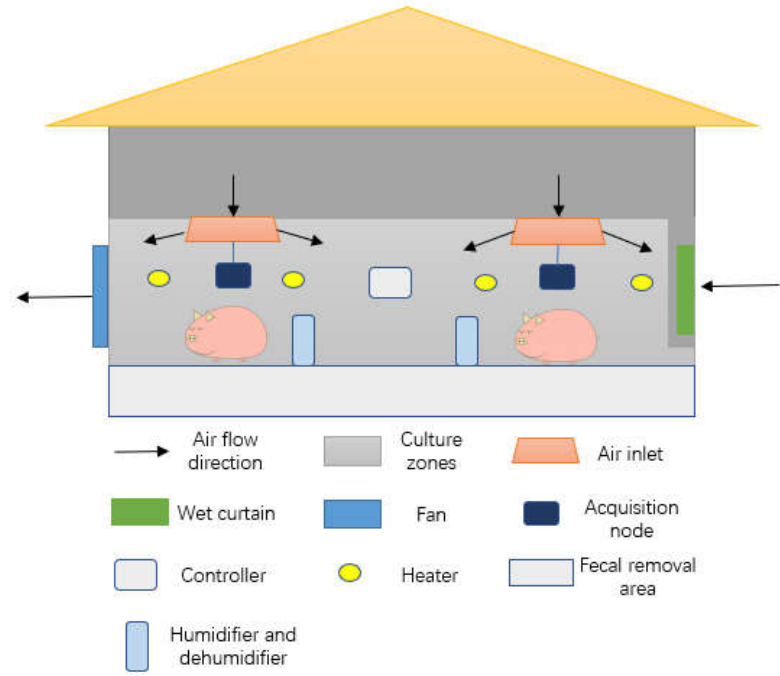
Figure 10. Cross-sectional view of experimental site.